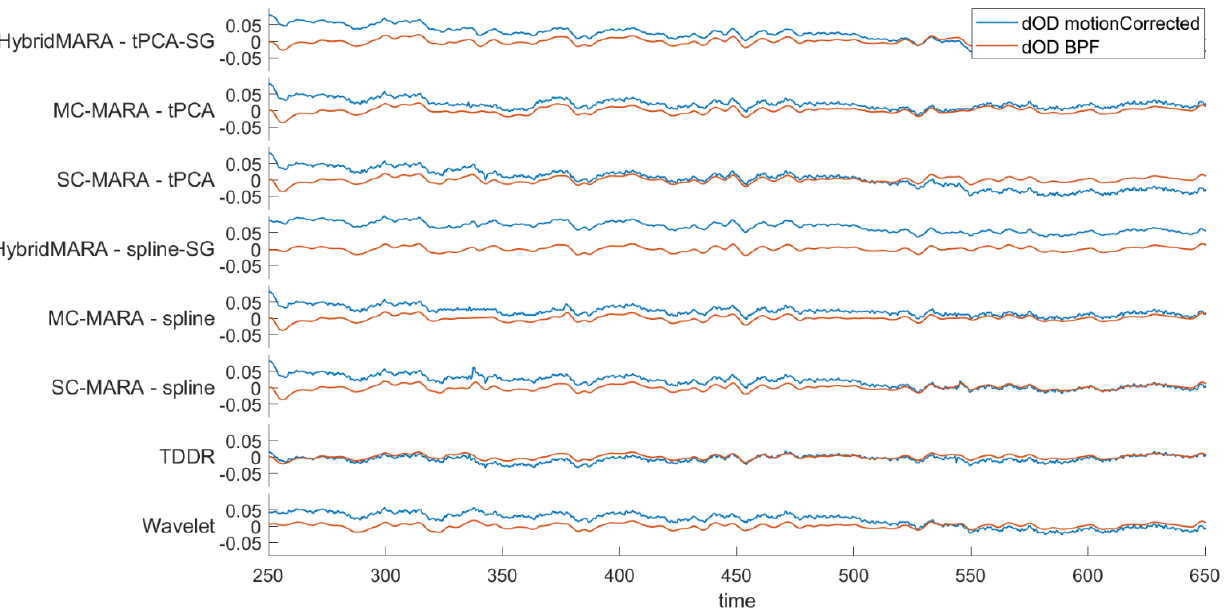
Figure 5. Single-channel graphical representation of the effect of BPF over Δ𝑂𝐷 signals across pipelines. Δ𝑂𝐷 signals are represented with respect to the MA-corrected signals (blue line-input signal) and after BPF step (red line-output signal).